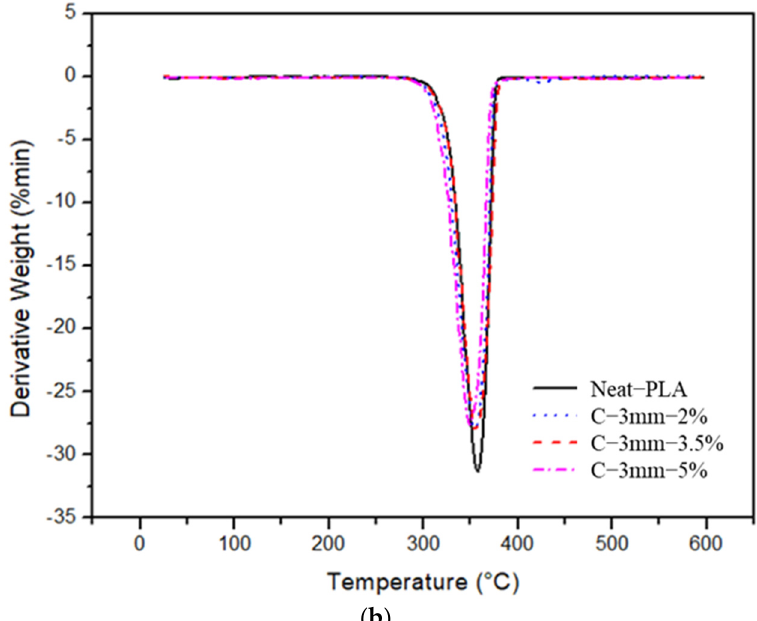
Figure 12. TGA analysis data: ( a ) TG curves; ( b ) DTG curves.